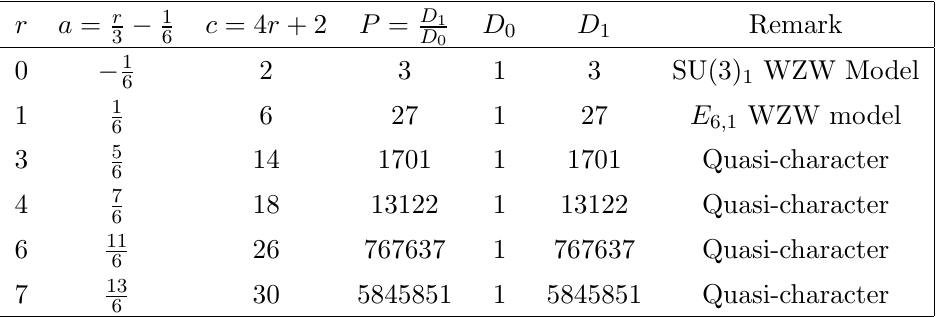
Table 5 . The A 2 series (Multiplicity M = 2).